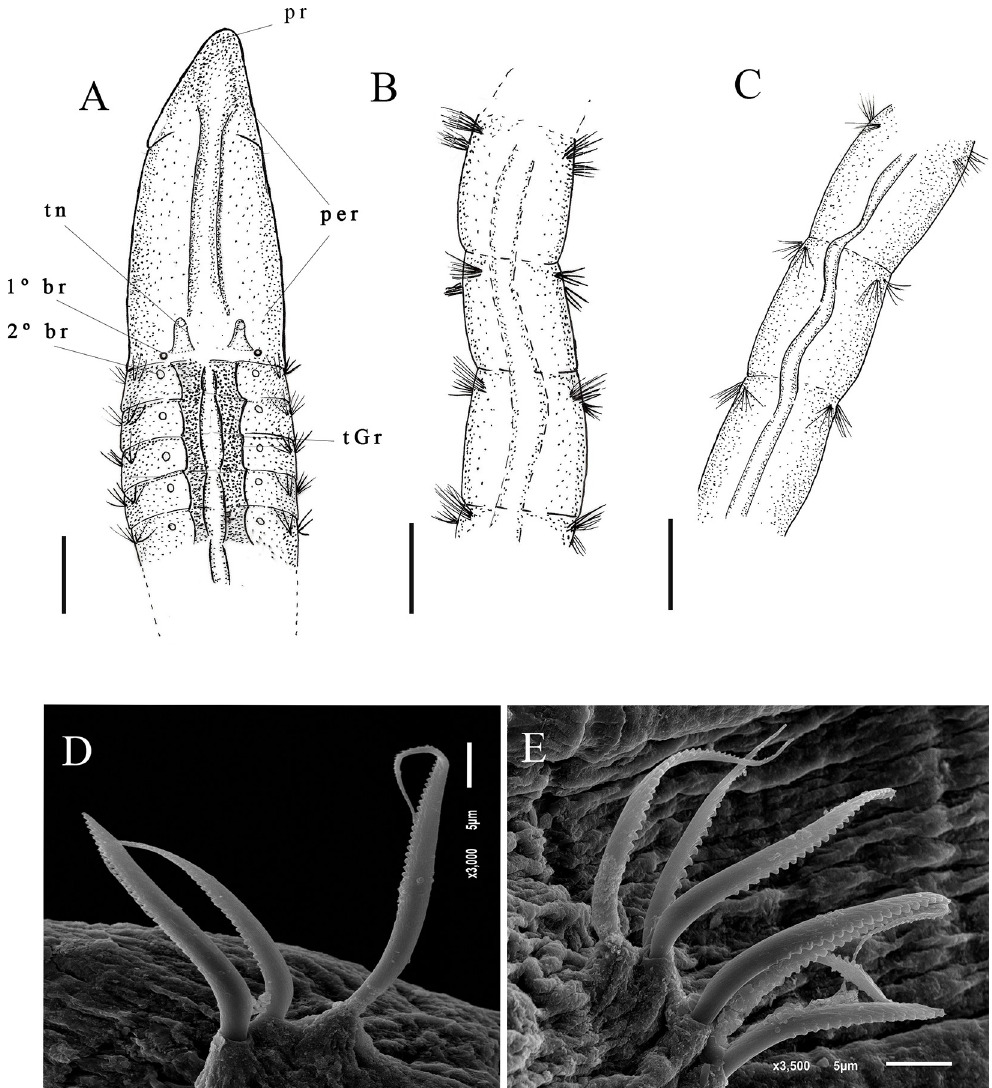
Fig 2. Kirkegaardia hampsoni . (A) anterior end, dorsal view; (B) segments of the anterior abdominal region; (C) segments of the posterior abdominal region; (D) notopodial setae in posterior region; (E) neuropodial capillary denticulated. A–C (MNRJP-002966). Scale bars: 100 μ m (A–C). Type locality. Atlantic Ocean: Massachusetts (USA) [27]. Habitat. Fine sediments, 30–150 m depth [27]. In the present study, fine sediments, mainly silt/clay, 19–683 m depth. Distribution. Atlantic Ocean: Massachusetts (USA) [27]; Campos Basin (Brazil). hampsoni . The present work represents the record of K . hampsoni for the South Atlantic Ocean. K . hampsoni , was found between 19 to 121 m in the Campos Basin whereas Blake [27] records K . hampsoni from between 30 to 150 m. According to Blake [22] K . hampsoni was reg- istered locally as Tharyx and/or Monticellina dorsobranchialis at various locations on the conti- nental shelf of the US Atlantic, from the Gulf of Maine to the mid-Atlantic, the Campos Basin record points out that K . hampsoni is a species with extensive distribution, but more in-depth studies on the distribution of Kirkegaardia species including K . hampsoni are needed. The samples from the Campos Basin are not complete, and it is not possible to observe the pre- pygidial region and the pygidium.